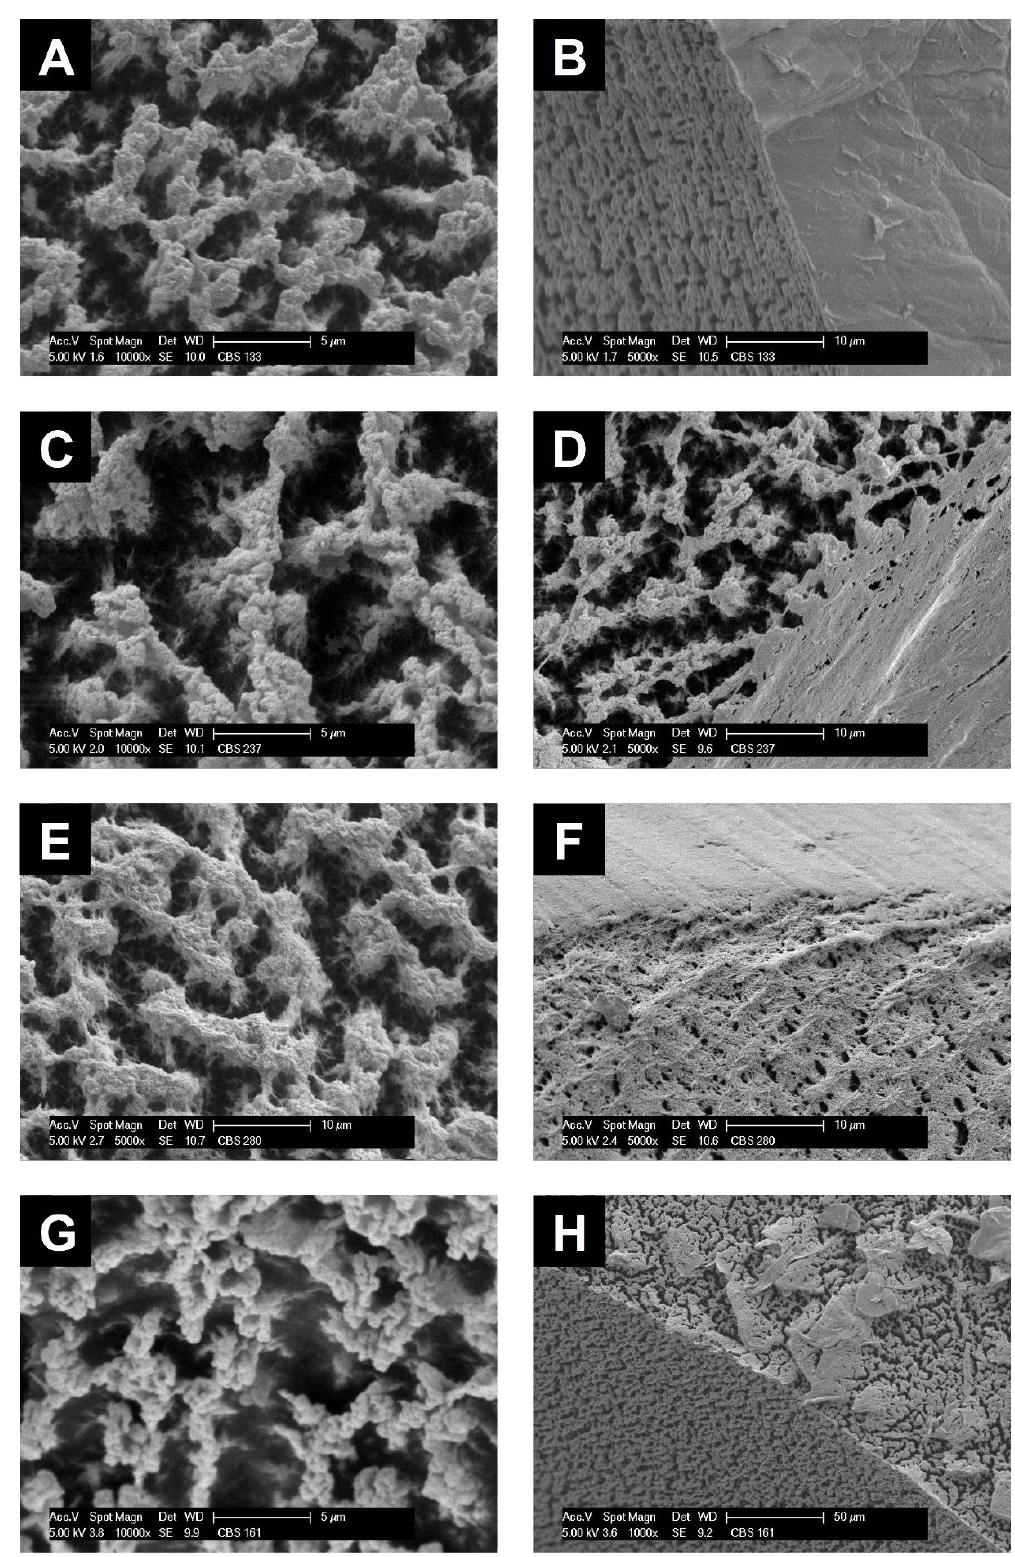
Figure 3. SEM micrographs of the interior ( A , C , E , G ) and near-surface breaking edge ( B , D , F , H ) of aerogels from non-derivatized cellulose (CL: A , B ; hwPHK: E , F ) and their phosphorylated counterparts (CL-P: C , D ; hwPHK-P: G , H ) at different magnification.